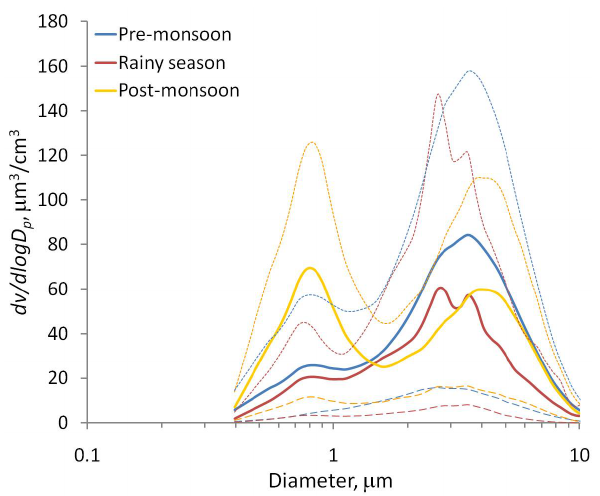
Fig. 5. The volume size distribution in Gual Pahari during different seasons, 0 . 4 <d p < 10µm. Solid lines are averages and dashed and dotted lines represent the 10th and 90th percentiles,